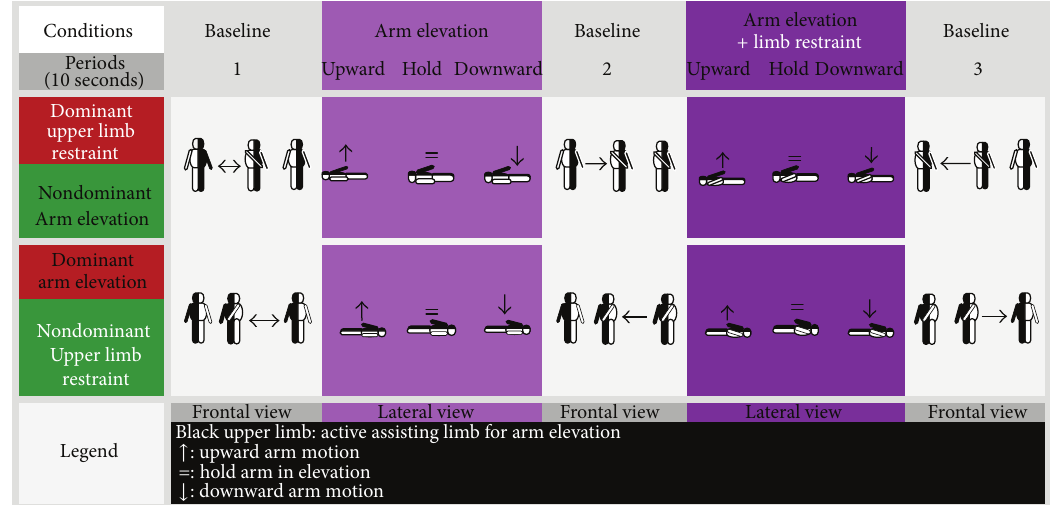
Figure 1: Schematic of experimental design in functional magnetic resonance imaging experiments. Limb manipulation during the experimental blocks (and control contralateral motion or restraint positioning during mid-period in baseline) is depicted by arrow symbols.